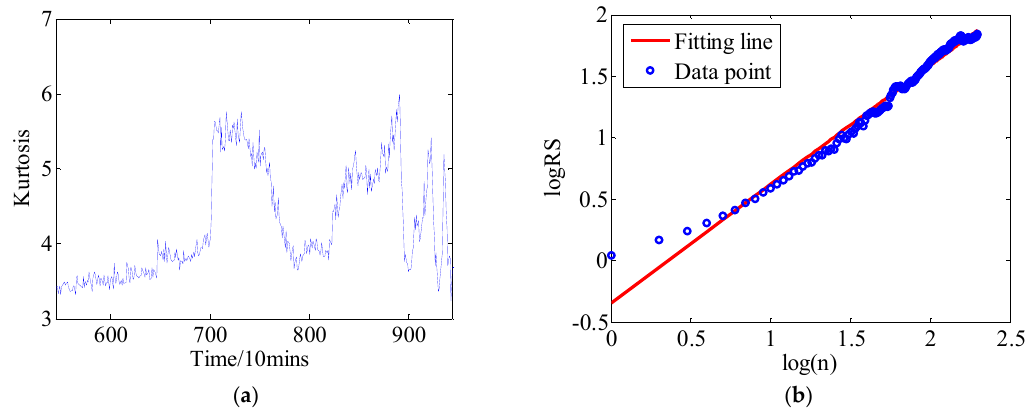
Figure 7. Kurtosis time series and its Hurst curve. ( a ) kurtosis time series with sharp transition points; ( b ) Hurst curve.